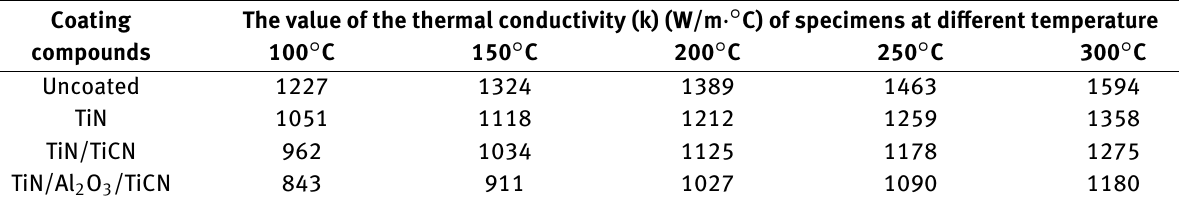
Table 2: Experimental results for the measurement of thermal conductivity of specimens Coating